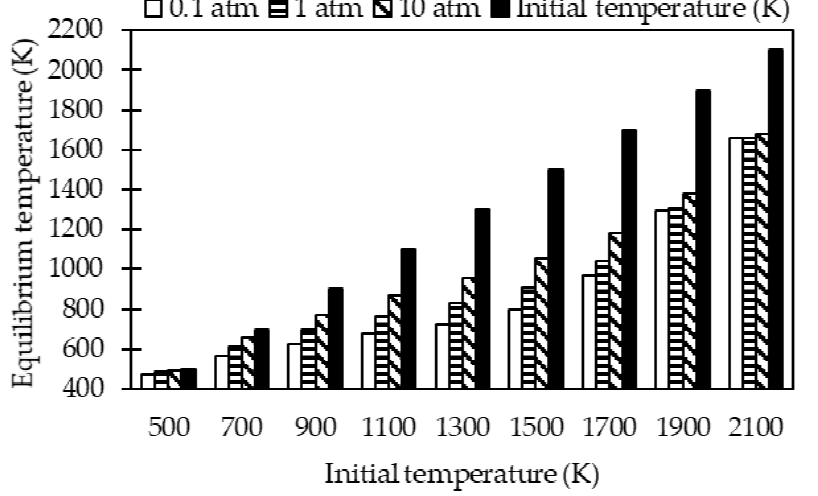
Figure 9. Thermal behavior of the methane cracking process as a function of initial temperature and pressure.